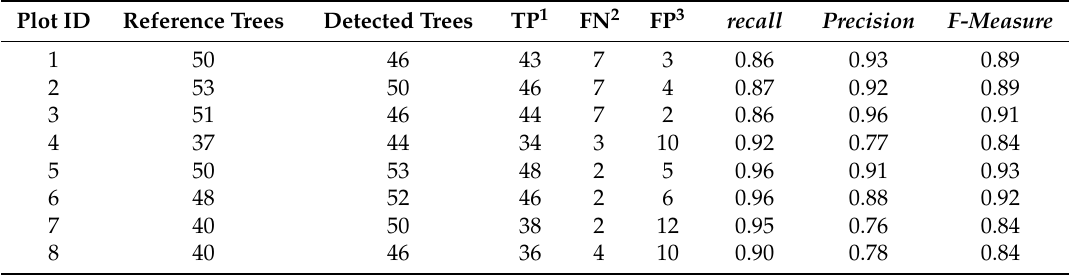
Figure 13. Individual tree segmentation and comparison of three sample plots. Table 2. Results of Individual Trees Segmentation in 15 Sample Plots.